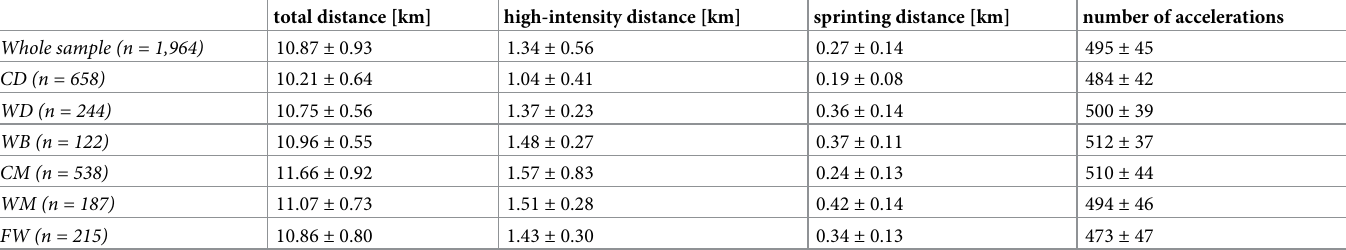
Table 1. Normative data for total distance, high-intensity distance, sprinting distance, and number of accelerations separated by playing position. Results are pre- sented as mean values ± SD. total distance [km] high-intensity distance [km] sprinting distance [km] number of accelerations Whole sample (n =